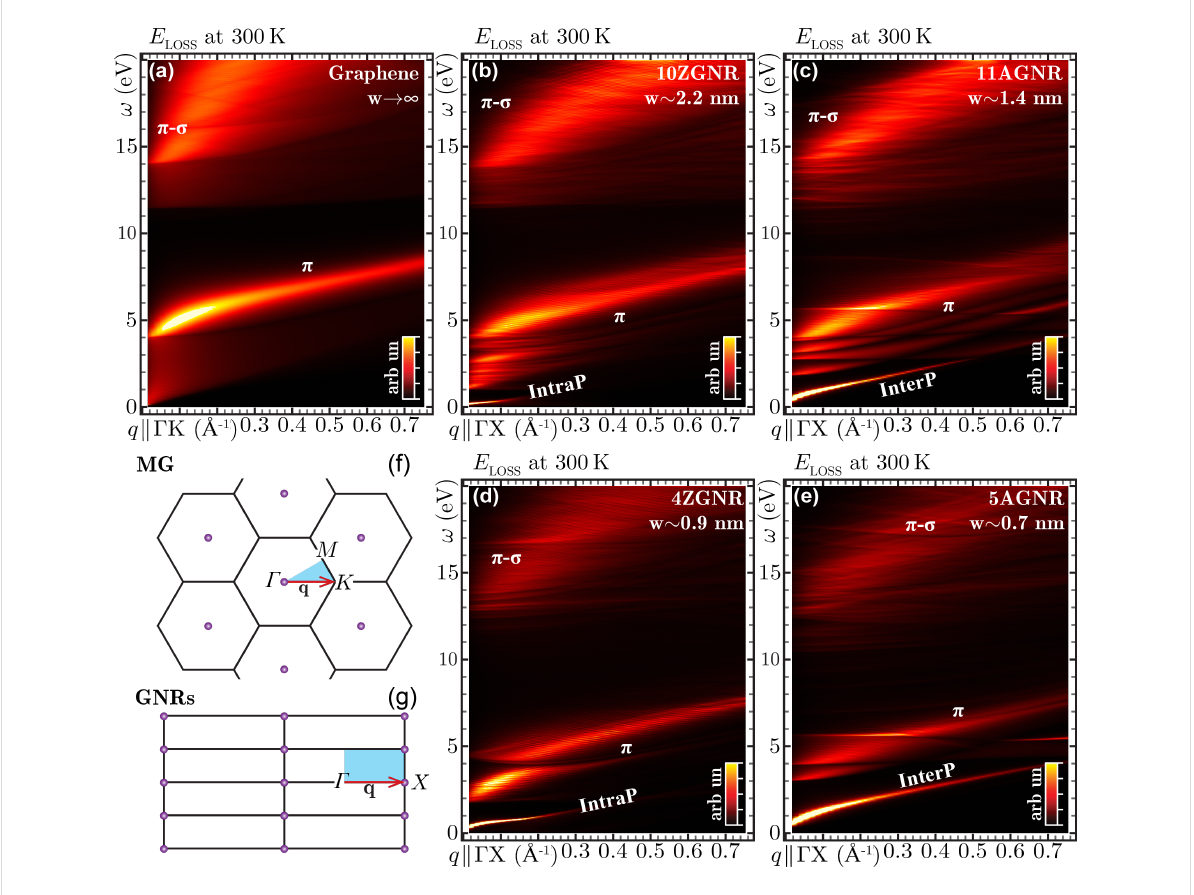
Figure 2: Loss properties of intrinsic graphene (a), i.e., an example of infinite-width GNR, and the undoped GNR arrays of Figure 1 (b–e), computed at room temperature from the TDDFT-RPA machinery summarized by Equations 1–8 of the main text. The EL function of Equation 8 is represented as a density-color plot vs incident energy ω (in eV) and momentum q (in Å − 1 ). The latter is sampled along the ΓΚ path of the 1st BZ of graphene (f), and the ΓΧ path of the 1st BZ of the different GNRs (g). Besides the π and π – σ plasmons, the ZGNRs present a low-energy intraband mode (IntraP), whereas the AGNRs have a low-energy interband mode (InterP). The intensity scale in (a–d) is cut at 80% of the π peak maximum, to ease compari- son between the different density-color plots.